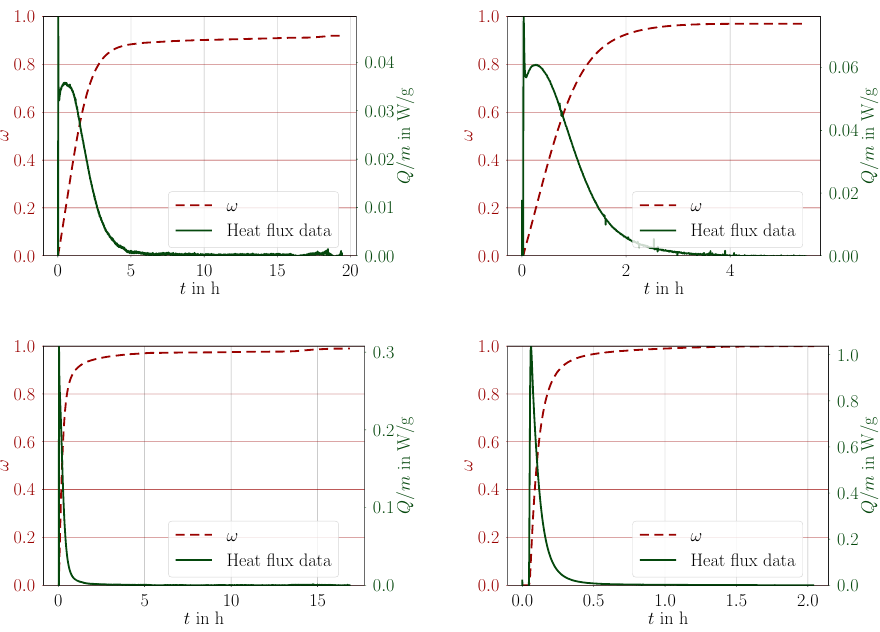
Figure 1. Experimental measurable heat flux (dashed, green line) and derived degree of cure (continuous, brown line) obtained during curing at 30, 40, 60, and 80 ◦ C isothermal conditions, for the material material A.